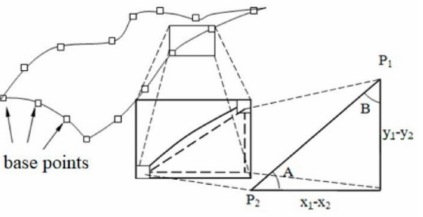
Figure 7. Segment of the analyzed image of the thermogram of the steel